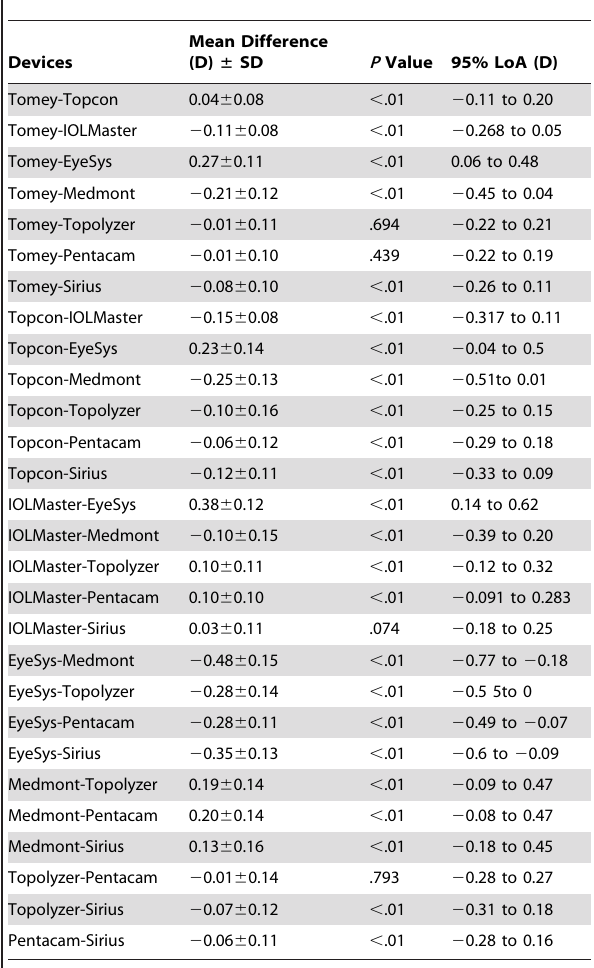
Table 6. Comparison of Mean Keratometry between 8 Different